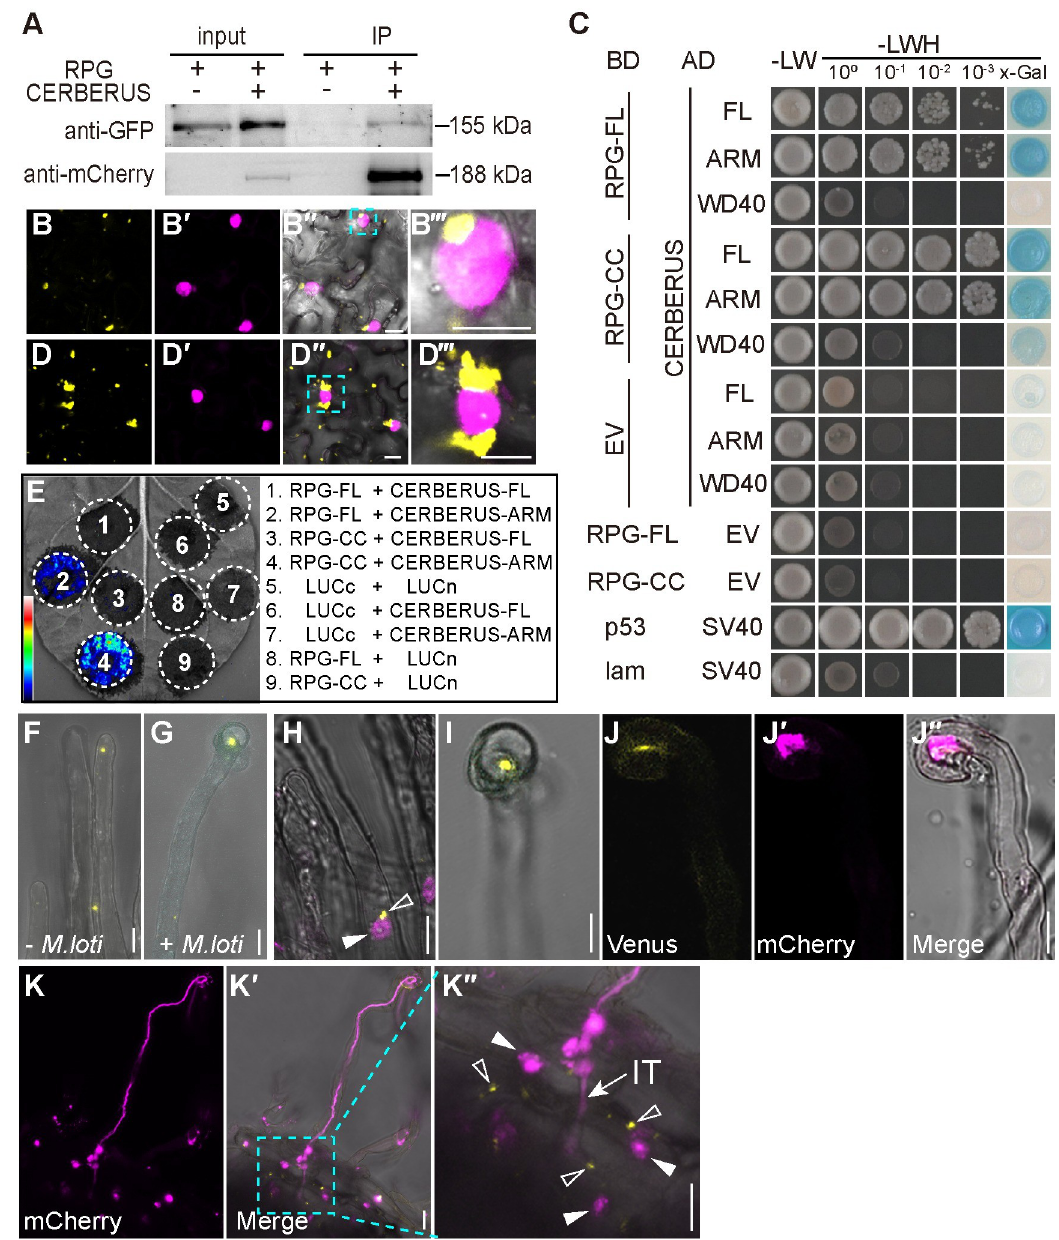
Fig 5. RPG interacts with CERBERUS. (A) Co-Immunoprecipitation (Co-IP) assay showing the interaction between GFP-RPG and CERBERUS-mCherry in N . benthamiana leaves. GFP-RPG and CERBERUS-mCherry were co-expressed in N . benthamiana leaves. Co-IP was assayed using anti-mCherry antibody, and the precipitated proteins were detected by immunoblot analysis with anti-mCherry and anti-GFP antibodies. One representative result out of two biological replicates is shown. (B and D) BiFC assays of full-length RPG and CERBERUS (B) or RPG-CC and CERBERUS-ARM (D) (yellow) and NLS-DsRed (magenta) in N . benthamiana leaves. The image shows strong Venus fluorescence localized in puncta, some of which were close to the nucleus. (B 000 and D 000 ) shows an enlargement of the area in outlined in cyan in the merged image (B @ and D @ ). (C) A GAL4-based yeast two- hybrid system was used to analyze the interaction between CERBERUS and full-length RPG (RPG-FL) or RPG lacking the NT-C2 domain (CC), and between CERBERUS ARM or WD40 and RPG-FL or RPG-CC. Potential interactions were assayed by growth on SD/-LWH (medium without histidine, leucine, or tryptophan) after gradient dilution. Images show the growth of co- transformants on selection media after three days. (E) Luciferase biomolecular complementation assays of the interaction between RPG and CERBERUS or RPG-CC and CERBERUS-ARM in N . benthamiana leaves. The indicated constructs were co-expressed in N . benthamiana leaves, and luciferase complementation imaging was conducted two days after agroinfiltration. LUCn, N-terminal fragment of firefly luciferase. LUCc, C-terminal fragment of firefly luciferase. Fluorescence signal intensity is indicated. (F-G)